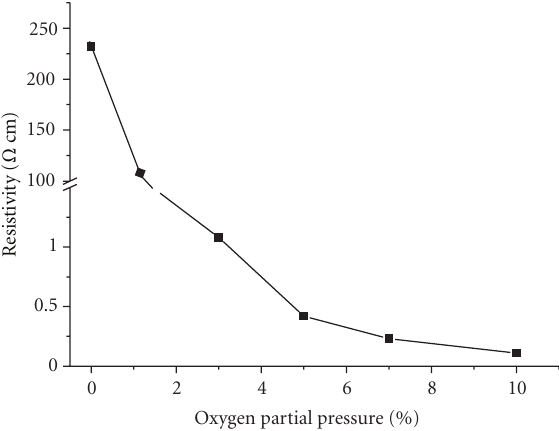
Figure 4: Electrical resistivity as a function of oxygen partial pressure percentage.